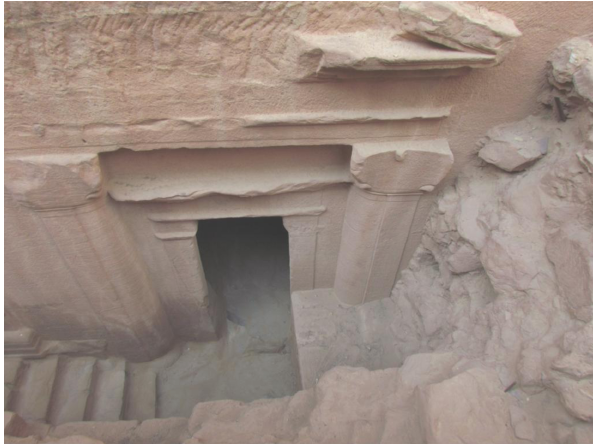
Figure 3. One of the doors, the right one, that are object of the 3D